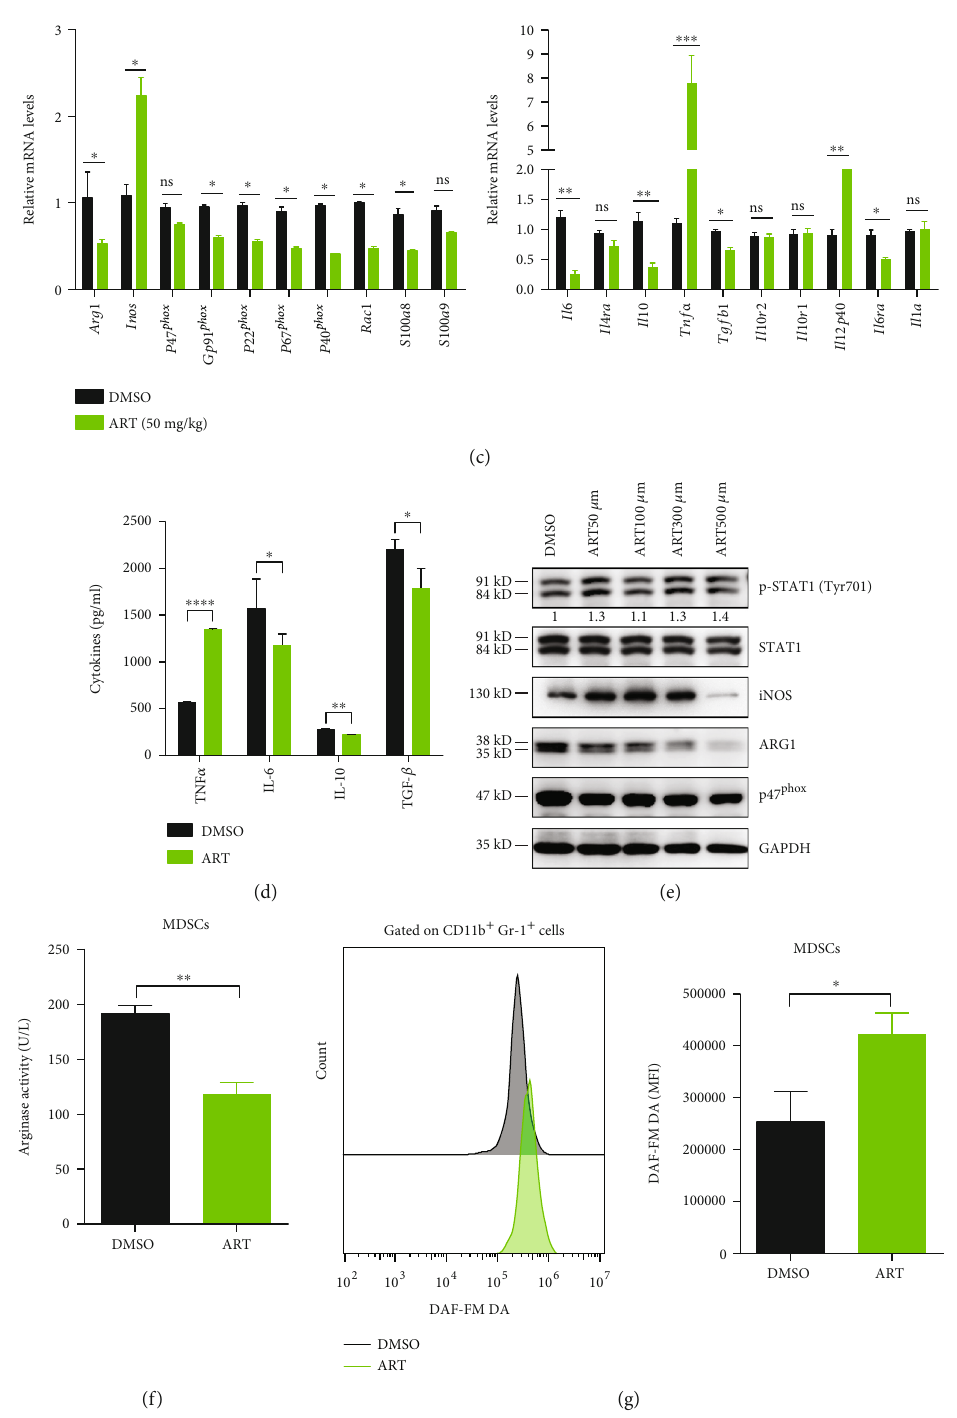
Figure 2: ART promotes to polarize MDSCs from M2-like protumoral phenotype towards M1-like antitumoral one. (a – g) Puri fi ed CD11b + Gr-1 + MDSCs from the tumors of B16F10 melanoma cell-bearing C57BL/6 mice treated with DMSO for 13 days or ART (50 mg/kg) for 18 days (both groups had the similar tumor volume ~ 1000mm 3 ). (a and b) Performed RNA sequencing (RNA-seq) and gene set enrichment analysis (GSEA) and (c) the expressions of M1 and M2 signature genes were detected by qPCR in tumor MDSCs. (d) The cytokines IL-6, IL-10, TNF- α , and TGF- β were detected by ELISA. (e) The expressions of p-STAT1 (Tyr701), STAT1, iNOS, ARG1, and p47 phox protein were detected by western blot. (f and g) Detected arginase activity by biochemical assays and nitric oxide content by DAF-FM DA fl uorescence using fl ow cytometry analysis. Data are means ± SEM and are from a representative experiment of three (f and g) or from two (c) independent experiments. Unpaired Student ’ s t test for (c) and (d) and (f) and (g). ∗ P < 0 : 05 , ∗∗ P < 0 : 01 , ∗∗∗ P < 0 : 001 , and ∗∗∗∗ P < 0 : 0001 . ns: not signi fi